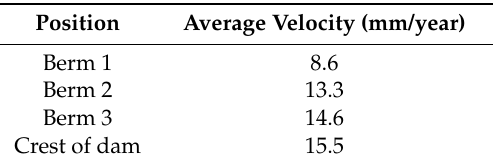
Table 3. DInSAR average vertical displacements